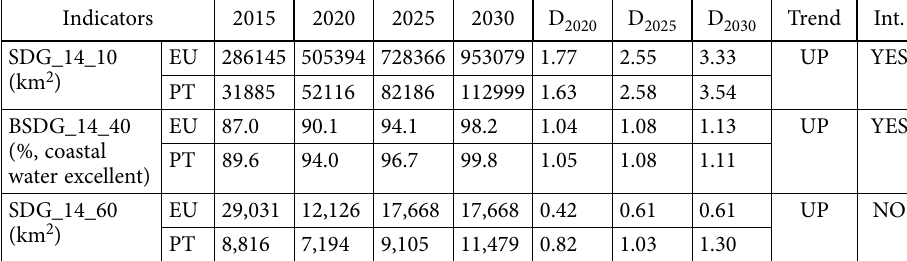
Table 15. SDG 14 – Life below water